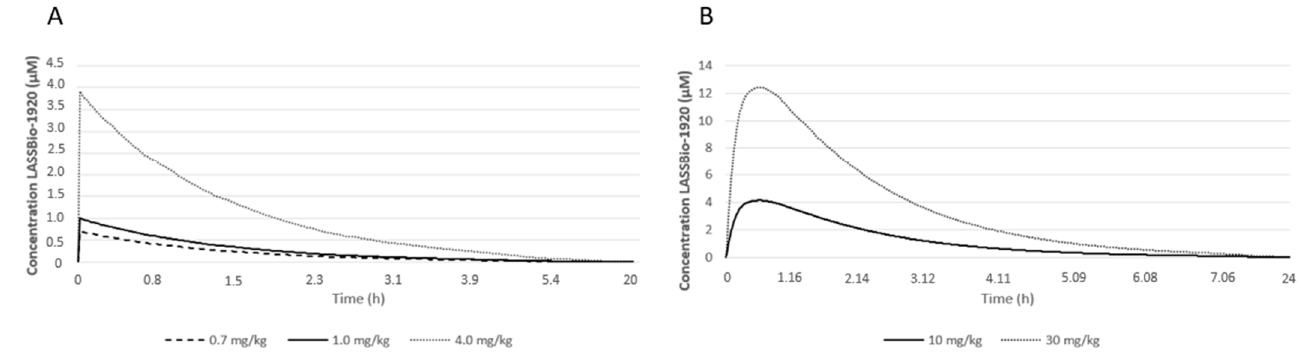
Figure 7. LASSBio − 1920 pharmacokinetic profiles in animal simulation module for IV ( A ) and for Figure 7. LASSBio-1920 pharmacokinetic profiles in animal simulation module for IV ( A ) and for oral ( B ) administration. oral ( B )